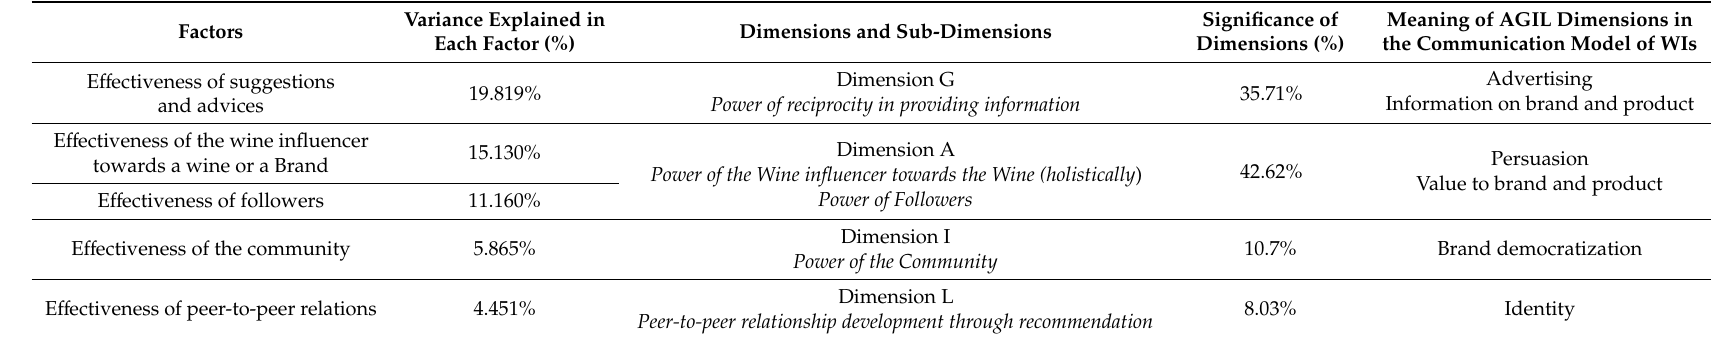
Table 4. Factors extracted by Factor Analysis (FA), percent variance explained by each factor, dimensions and sub-dimensions of the AGIL scheme, calculated significance of AGIL dimensions, and the meaning of dimensions in the Communication Model of Wine